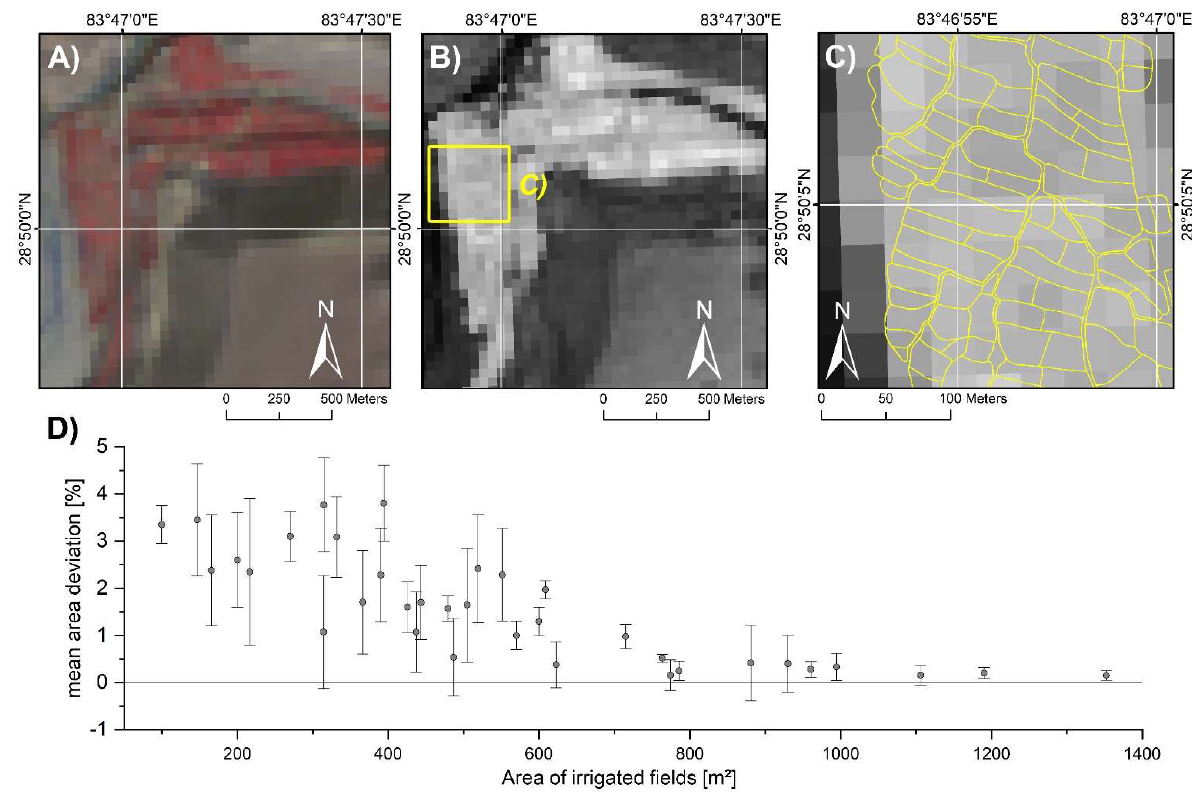
Figure 5. Comparison of Landsat OLI scenes with the mapping approach performed in this study: ( A ) False color composite (band 5-4-3) and ( B ) Normalized Difference Vegetation Index (NDVI) of Kagbeni settlement. ( C ) Manually digitized field boundaries (background image NDVI). The zoomed area of ( C ) is displayed as yellow box in ( B ). (Source: Landsat OLI available from the U.S. Geological Survey; acquisition date 14 October 2021). ( D ) Mean area deviation and standard deviations of 35 multiple digitized fields. Table 1. Statistics of the land tenure plots at the investigated settlements in 2018 and distinctive transformations relative to the total area of the irrigated fields since the early